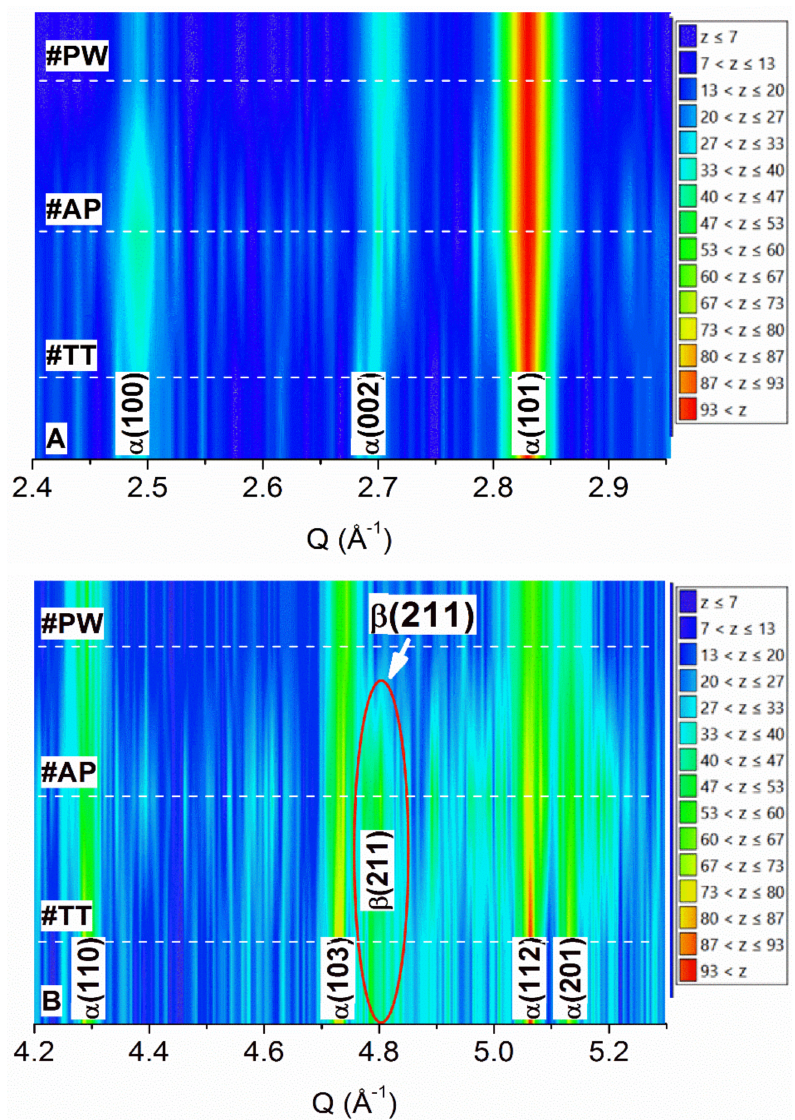
Figure 1. Neutron di ff raction (ND) intensity color map of the three investigated samples for two di ff erent ranges of the scattering vector Q: ( A ) low-value range Q = 2.4 − 2.95 Å − 1 ; ( B ) high-value range Q = 4.2 − 5.3 Å − 1 . Miller indices of peaks from α -Ti and β -Ti phases are reported. The color code on the right of figures indicates peak intensity range. Di ff raction e ff ect due to the β -Ti high-temperature phase in samples #AP and #TT is evidenced by the red ellipse in Figure